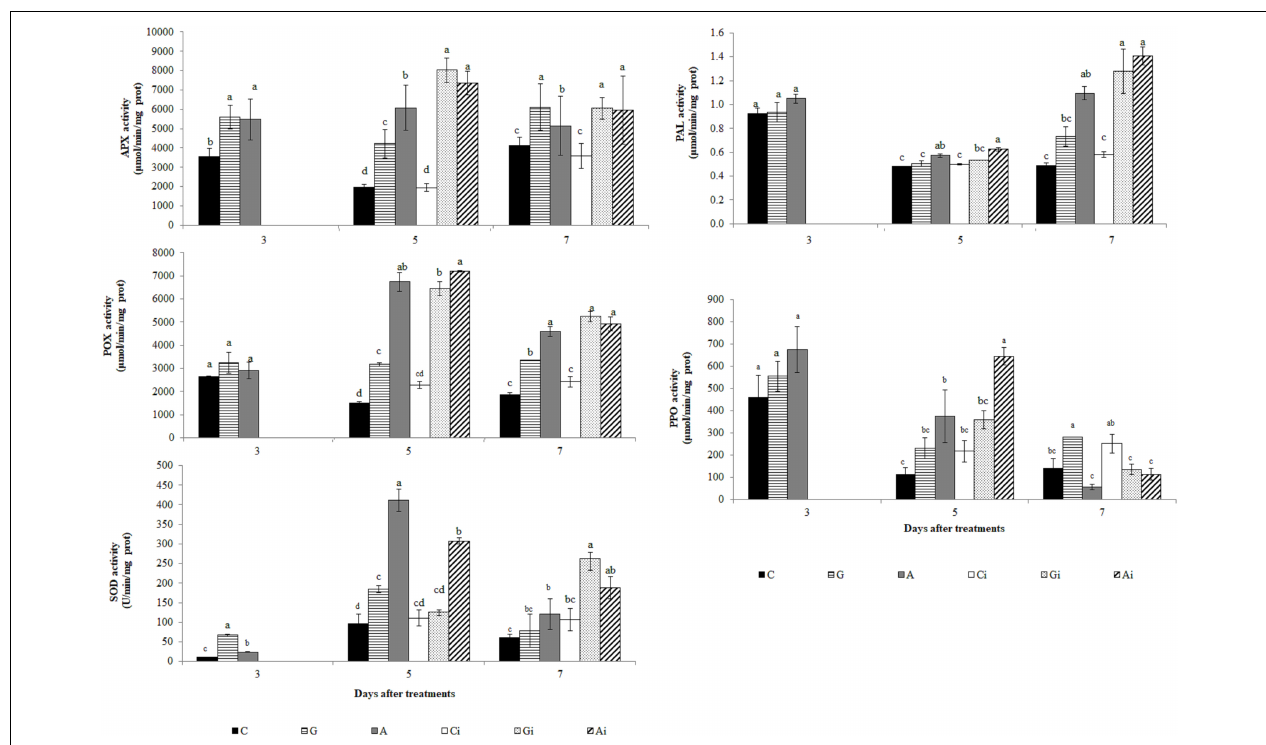
FIGURE 11 | Evaluation of APX, POX, SOD, PAL and PPO activities in coffee leaves treated with the PRIs Greenforce CuCa (G), ASM (A), and control (C) and inoculated with H. vastatrix (i). Inoculation occurred 3 days after treatment with PRIs. The means from the treatments, at each evaluation time, followed by different letters were significantly different ( p ≤ 0.05) according to Tukey test. Bars represent the standard